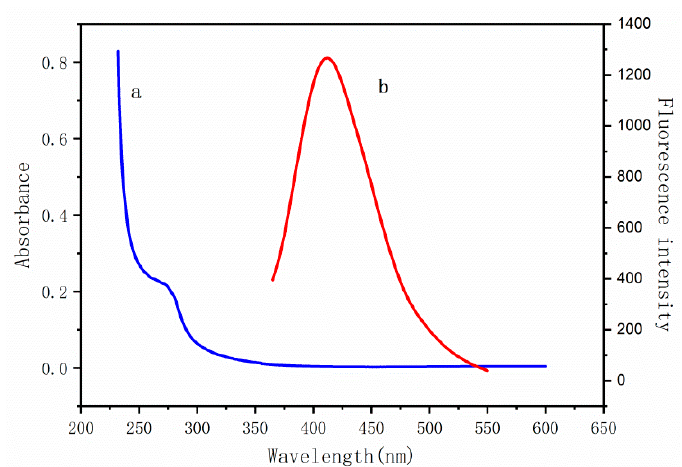
Figure 2. Absorbance ( a ) and fluorescence emission ( b ) spectra of the BSA-Cu NCs.